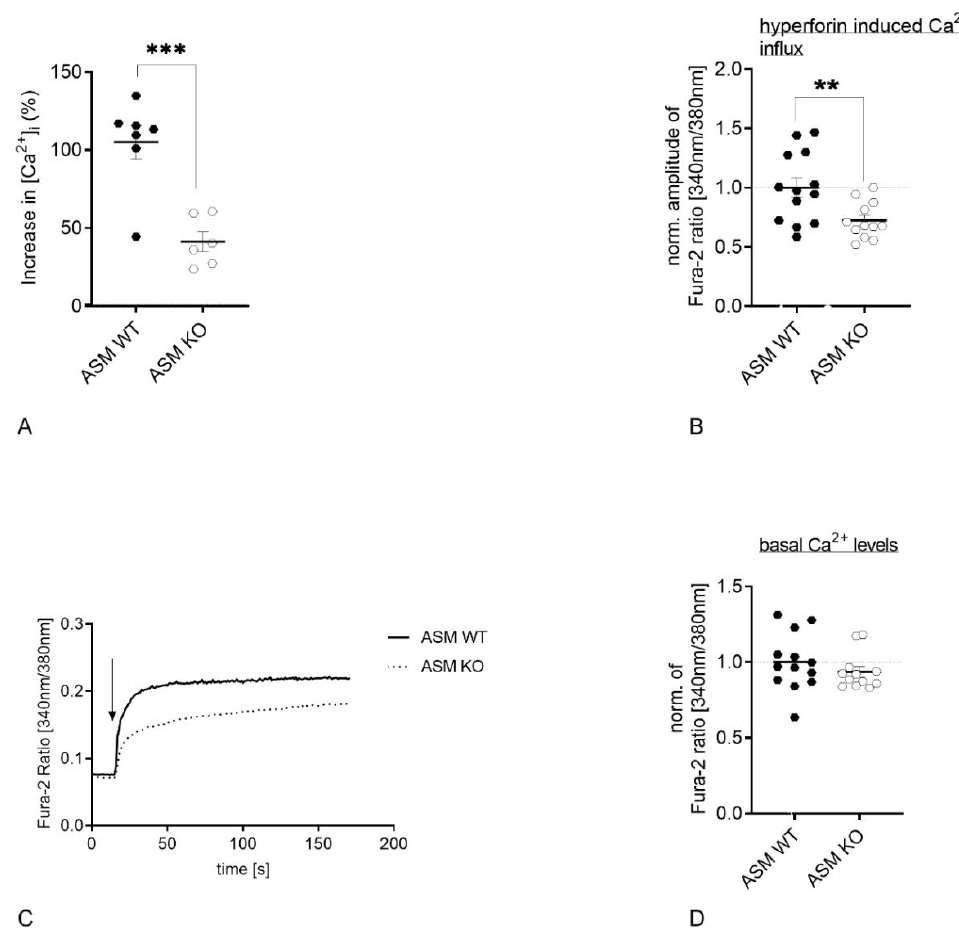
Figure 4. Genetic ASM deficiency decreases TRPC6-mediated Ca 2 + influx in synaptosomes and cultured primary murine neuronal cells. ( A ). Hyperforin-induced (10 µ M) Ca 2 + influx in murine brain synaptosomes, isolated from ASM KO mice, was reduced compared with synaptosomes isolated from ASM WT mice ( n = 6 animals). ( B ). Application of hyperforin 10 µ M activates TRPC6-mediated Ca 2 + influx. The amplitude of change in intracellular Ca 2 + concentration is diminished in cortical ASM KO neurons compared with cortical ASM WT. ( C ). Representative time-curve of TRPC6-mediated Ca 2 + influx in cortical mouse neurons. Arrow indicates the application of hyperforin 10 µ M. ( D ). Baseline Ca 2 + concentrations of ASM KO and ASM WT cortical neurons do not di ff er. Bars indicate mean ± SEM; n = 4 cell batches, 1–4 cover slips per batch were analyzed; ** p ≤ 0.01, *** p ≤ 0.001.